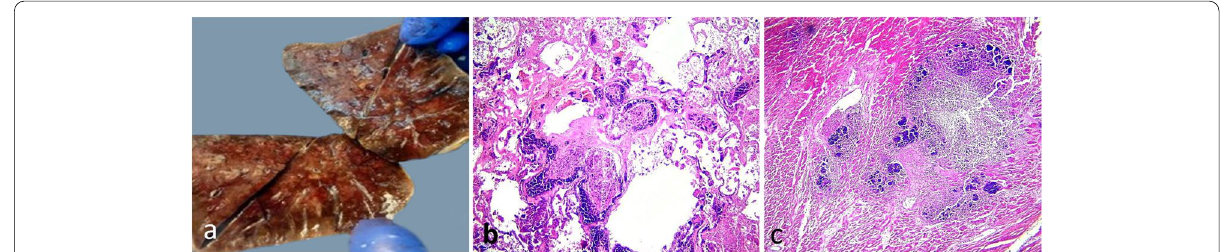
Fig. 4 Septicemia. a A cross‑section of the lung with multiple yellowish foci and dark areas of hemorrhages denote septic pneumonia; b histopathological picture of neutrophilic bronchopneumonia with multiple abscesses containing germ colonies and septic emboli at the interstitial blood vessels (H&E 40); c histopathological picture of neutrophilic myocarditis with multiple abscesses containing germ colonies and septic × emboli at the interstitial blood vessels (H&E 40) ×